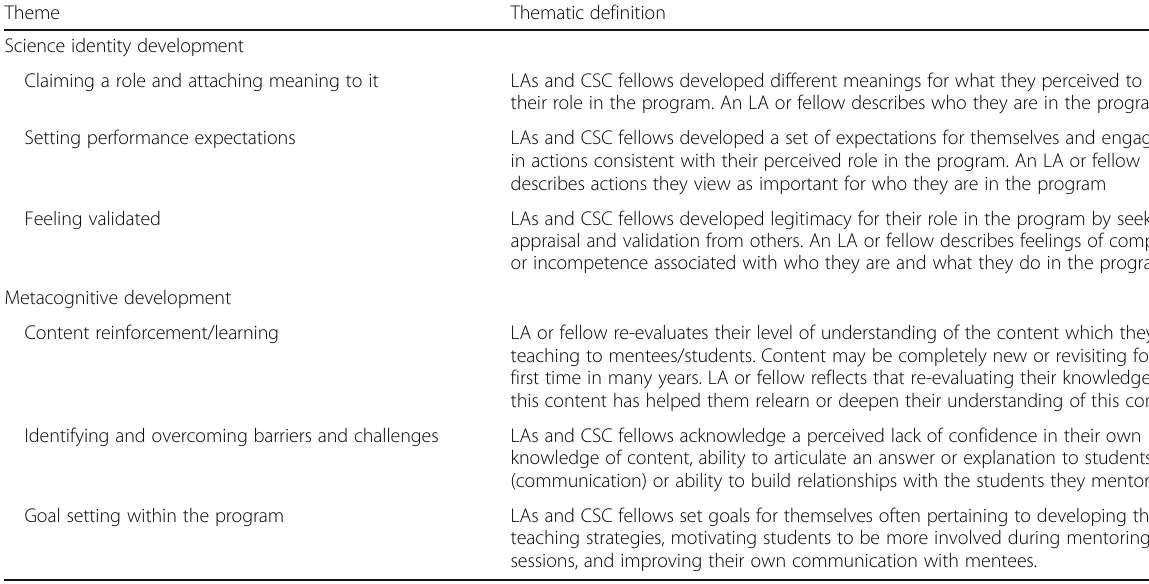
Table 3 Themes of science identity and metacognitive development in UMTs